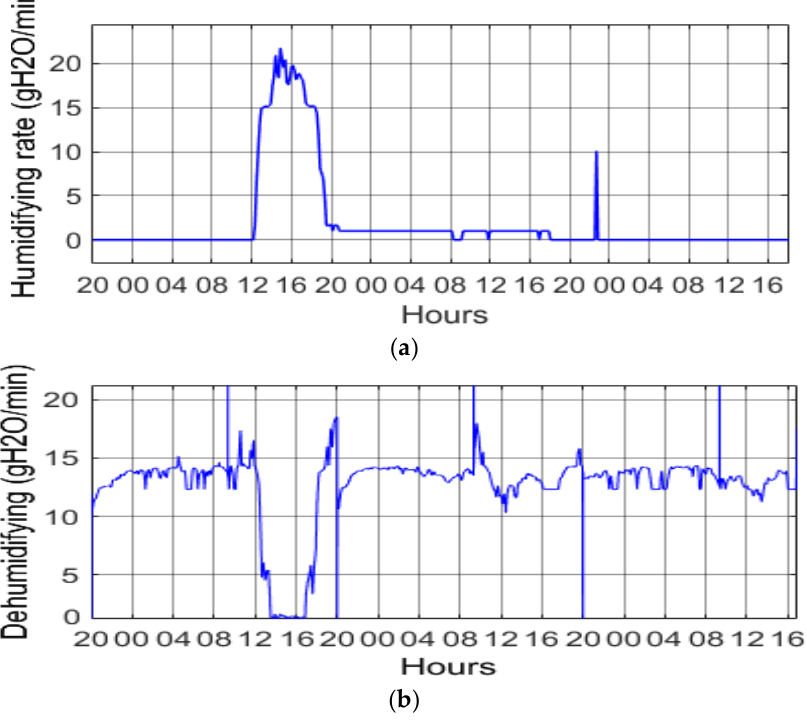
Figure 17. The humidification rate ( a ) and the dehumidification rate ( b ) computed from the fuzzy controller.